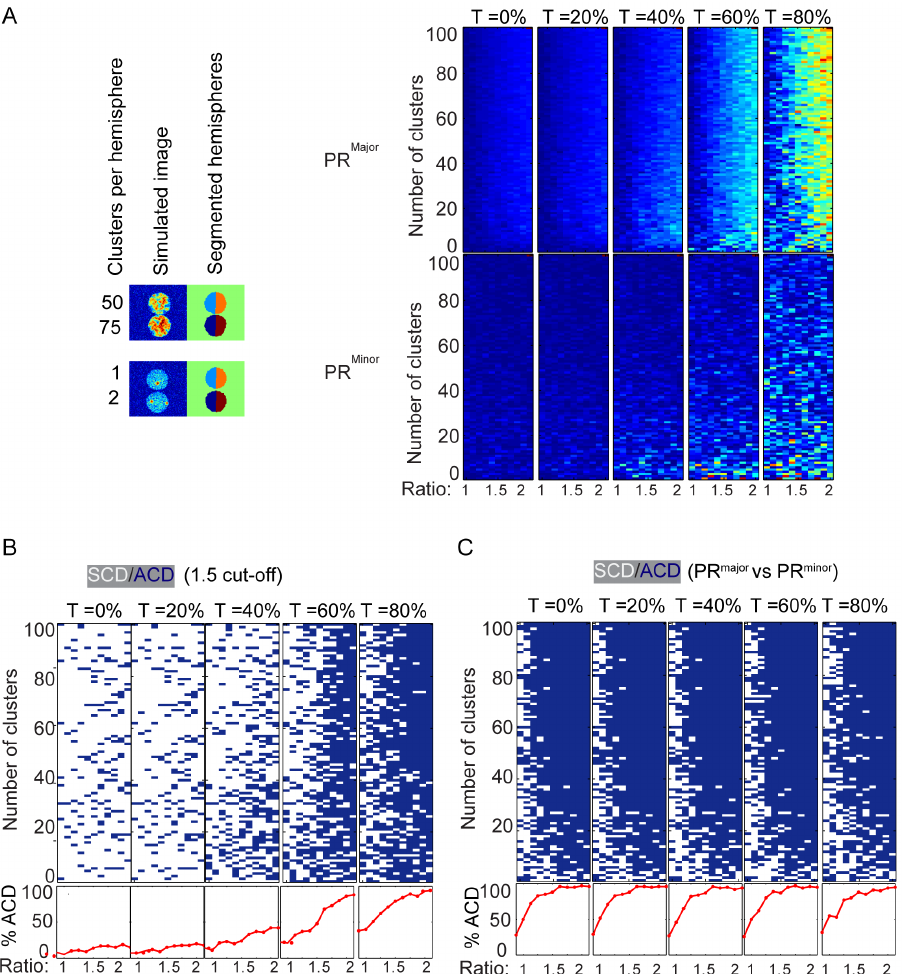
Figure 5. The effect of cluster number on the accuracy of PR measurements. Divisions were simulated to have increasing numbers of clusters ranged from 1 to 100 in increments of 1 for one of the daughter cells. The number of clusters in the second daughter was the number of clusters in daughter 1 multiplied with its corresponding ratio. Ratios vary from1 to 2 with increments of 0.1, and were calculated under 0%, 20%, 40%, 60%, and 80% threshold. ( A ) The PR major and PR minor for each event are shown in heat maps, where the PR ranging from 0 to 1 are represented in "jet" colors (blue to red). The ratios were binarized using ( B ) cut-off value of 1.5 or ( C ) by equation 5. Blue pixels represent events in which PR major was larger than PR minor ; white pixels represent events in which PR major was smaller than PR minor